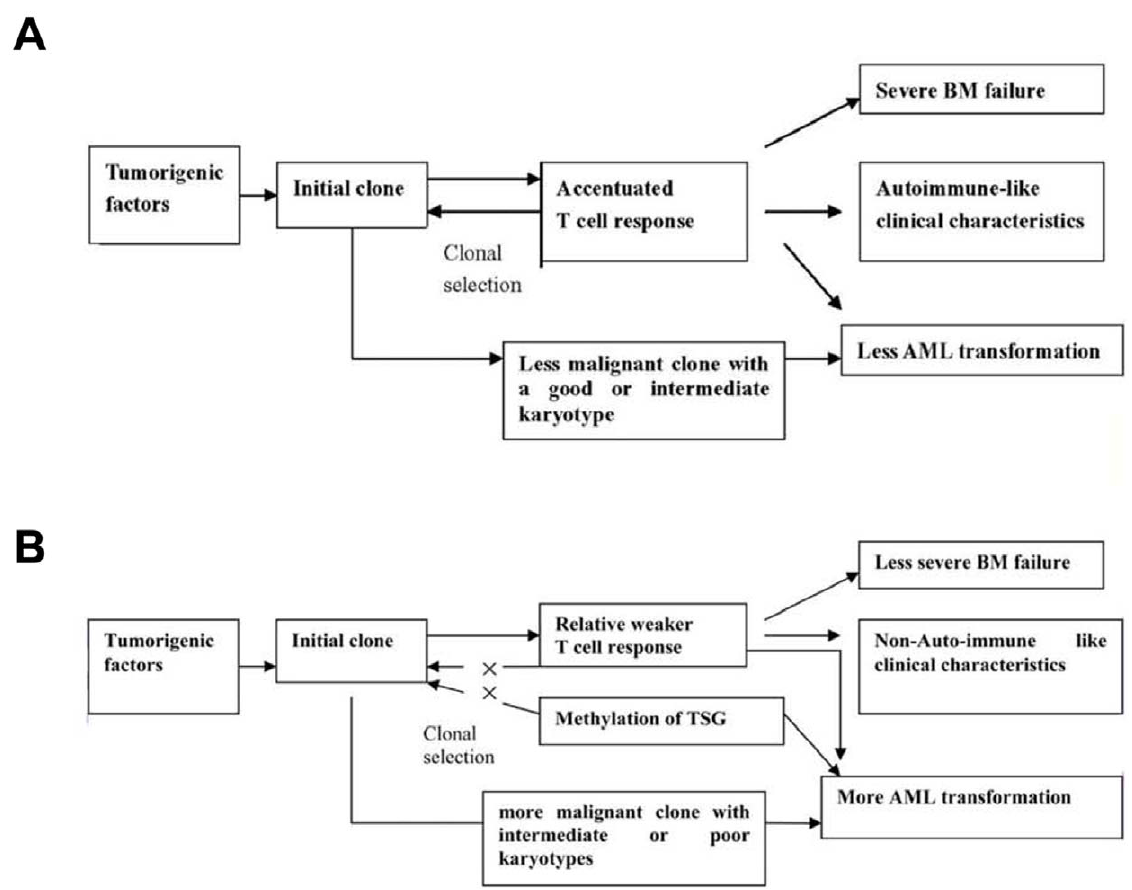
Figure 5. (A) Possible pathogenesis in younger patients; (B) Possible pathogenesis in older patients.